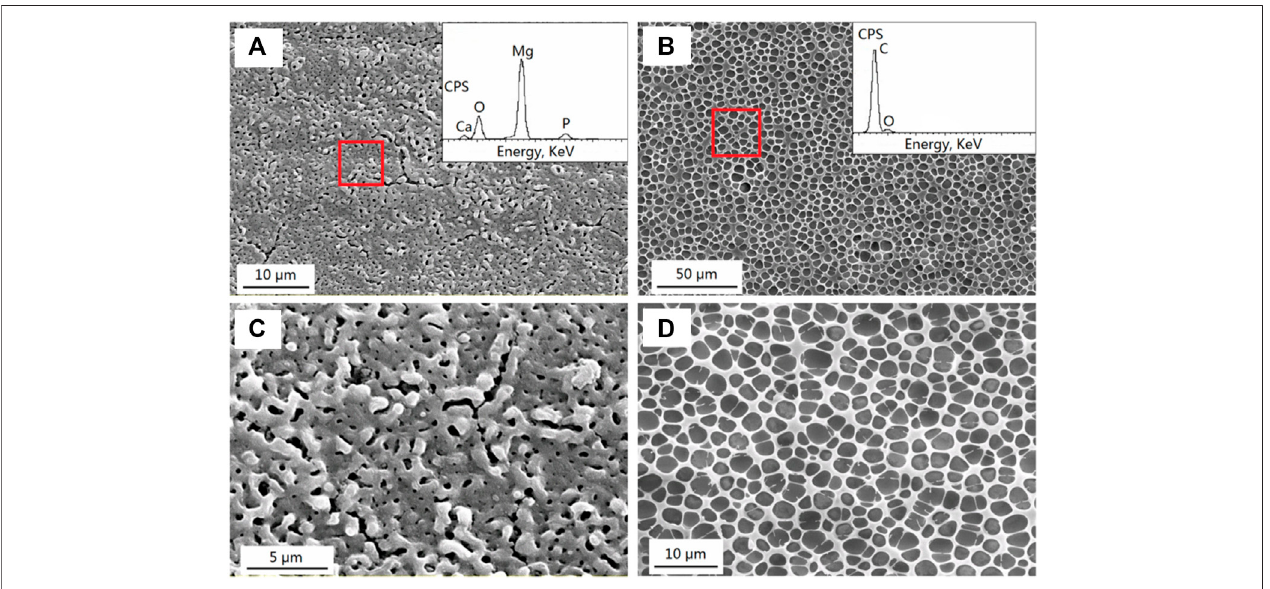
FIGURE 3 | SEM morphologies with EDS spectra; (A) MAO coating; (B) MAO/PLLA composite coatings on the Mg − 1Li − 1Ca substrate; (C) and (D) show higher magni fi cation of (A) and (B) , respectively. Reprinted with permission from (Zeng et al., 2016), Copyright 2016, American Chemical Society.